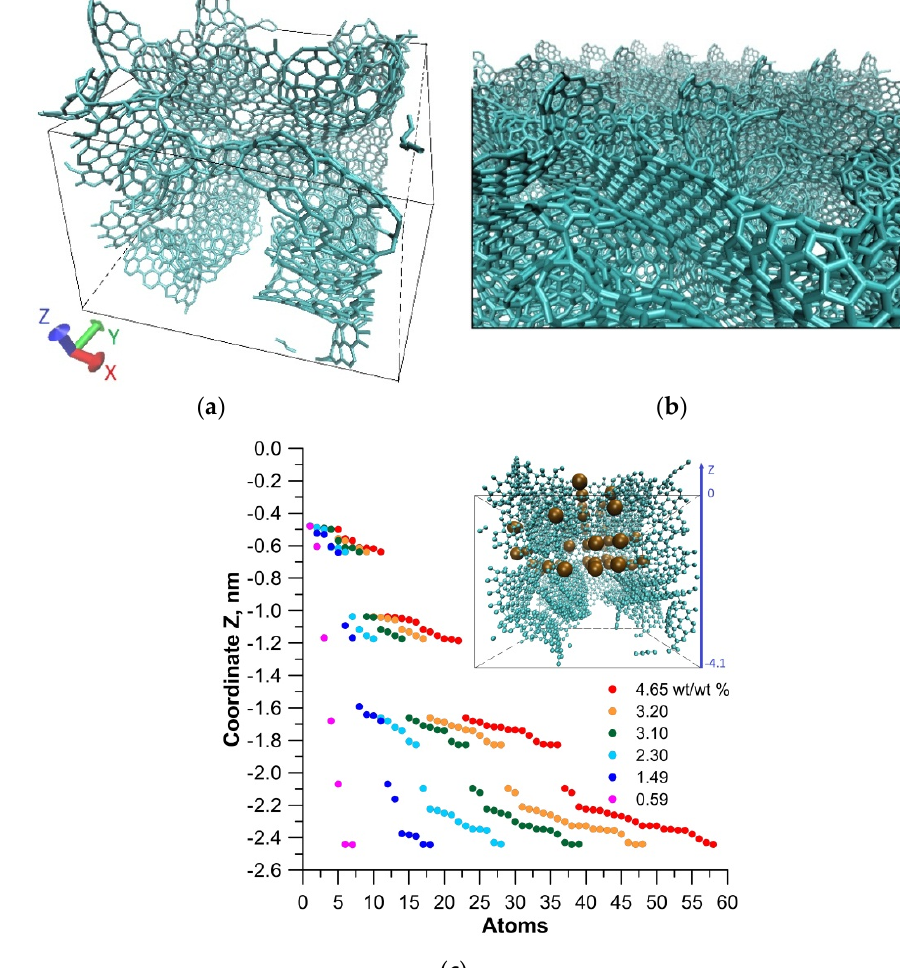
Figure 2. A surface of porous glass-like nanomaterial: ( a ) a super-cell of the film, which is the glass-like nanomaterial surface; ( b ) a topology of the atomic model surface; ( c ) a distribution of potassium atoms (balls of ocher color) by nanopores at different concentrations (mass fraction).